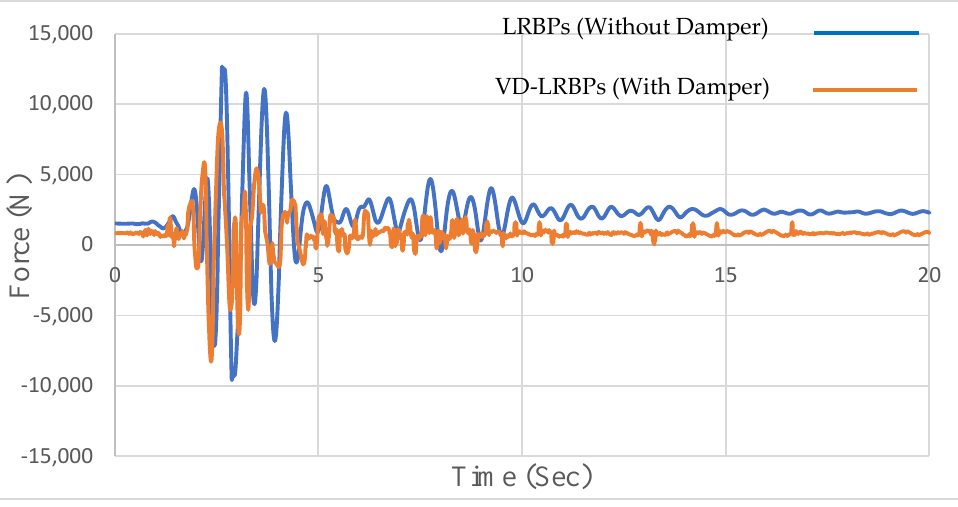
Figure 23. Force histories that pier 1 experiences under the Kobe (Japan) earthquake.